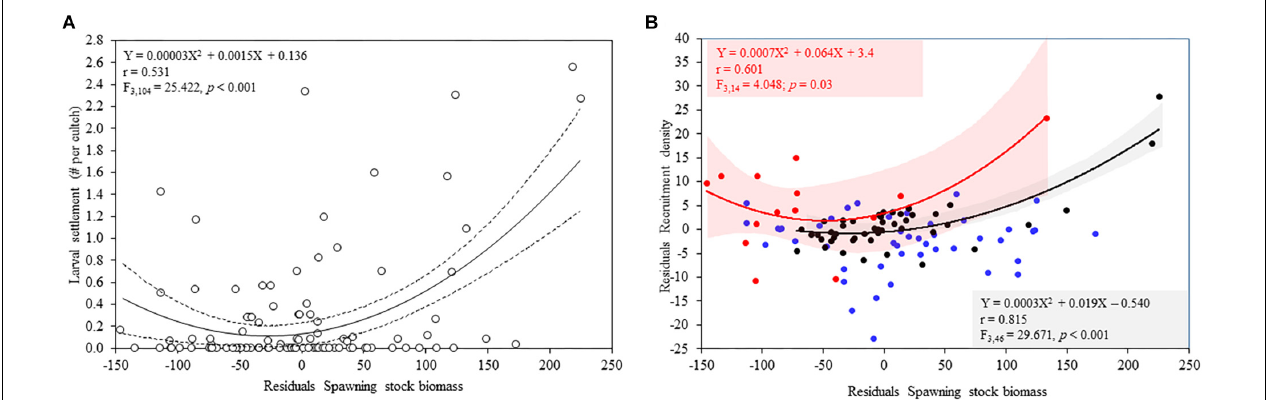
FIGURE 4 | (A) Assessment of the relationship between the spawning stock biomass (SSB) versus the log-transformed number of settled postlarvae of A. atra ; broken lines represent the 95% confidence interval for the regression line. (B) Assessment of the relationship between the SSB and the density of recruits during EN, LN and neutral conditions. EN is denoted by red dots, LN by blue dots and neutral conditions by black dots. Red and gray shadows represent the 95% confidence intervals for the regression lines.